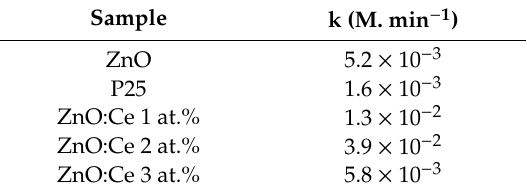
Table 3. Numerical values of the e ff ective rate constant estimated using the LH model.